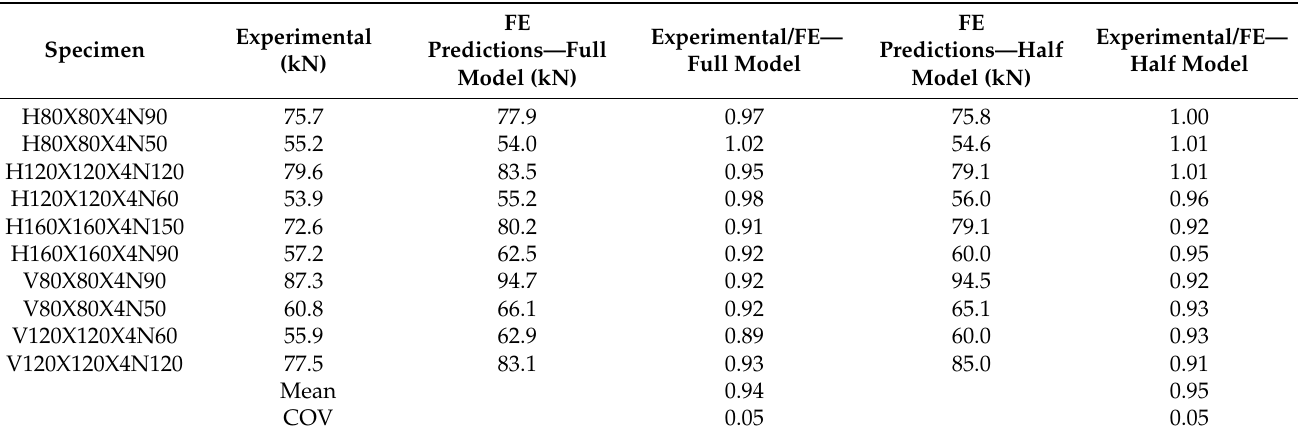
Table 2. Comparison of web crippling test strengths with FE results for tubular sections under the ETF loading condition [2,5].